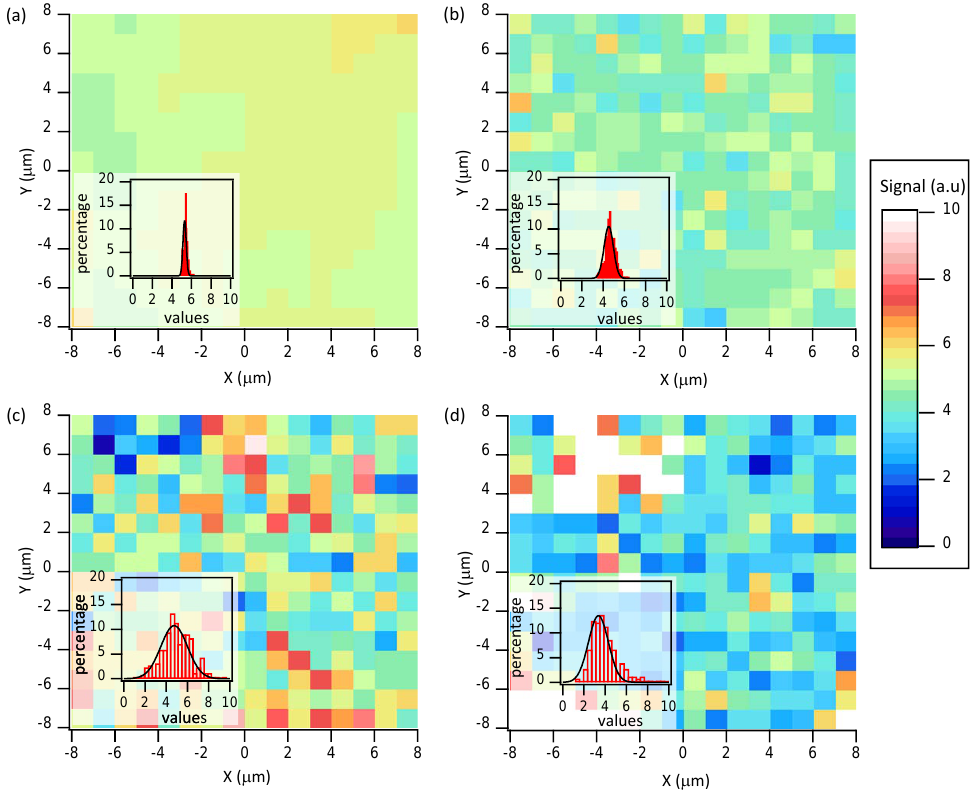
Figure 5. SERS scan of the 1588 cm − 1 peak for 4-MBA adsorbed on different gold NP monolayers prepared at the optimal lateral pressure and an electroless plating time of 8 min. Data correspond to gold nanostars ( a ), 10 nm gold NP ( b ), 5 nm gold NP ( c ), and 30 nm gold NP ( d ). The distribution of intensities is plotted as an inset in each case, and a Gaussian is fitted to each distribution as a guide for the eye.